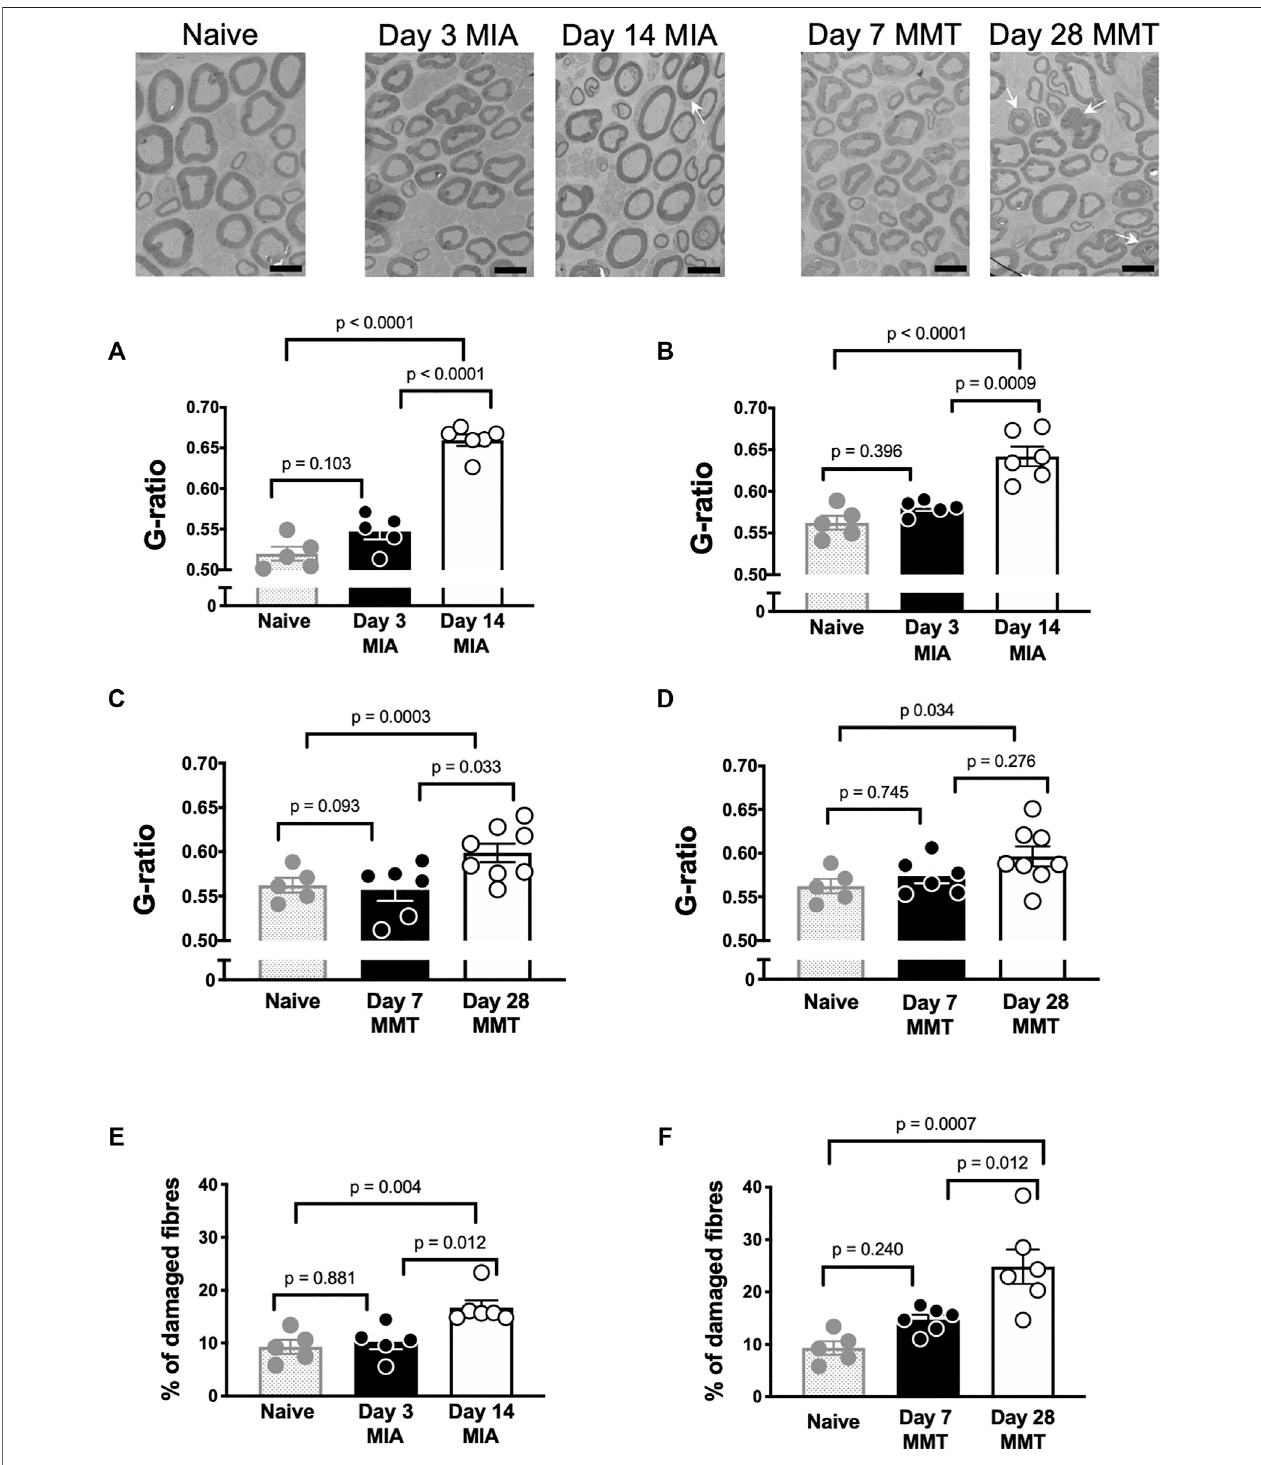
FIGURE 2 | Joint Nerve Damage in the MIA and MMT models of Arthritis. Representative electron micrographs of the saphenous nerve from naïve, MIA, and MMT animals. G-ratio values were signi fi cantly different when comparing the day 14 timepoint in the MIA model with both naïve and day 3MIA animals; both in smalldiameter axons (A) andlarge diameteraxons (B) ( p < 0.05, n (cid:1) 5 – 6,1-wayANOVA). G-ratiovaluesdidnot signi fi cantlydifferbetweenday 7andday 28MMTforsmall (C) orlarge (D) diameter axons ( p > 0.05, n (cid:1) 5 – 6, 1-way ANOVA). The percentage of damaged axons (arrows) was signi fi cantly higher in day 14 MIA animals compared to naïveandday3MIA (E) ( p < 0.01, n (cid:1) 5 – 6,1-wayANOVA).Thepercentageofdamagedaxons(arrows)wasalsosigni fi cantlyhigherinday28MMTanimalscomparedto naïve and day 7 animals (F) ( p < 0.05, n (cid:1) 5 – 6, 1-way ANOVA). Data presented as means ± SEM. Arrows indicate damaged axons, scale bar (cid:1) 6 μ m.